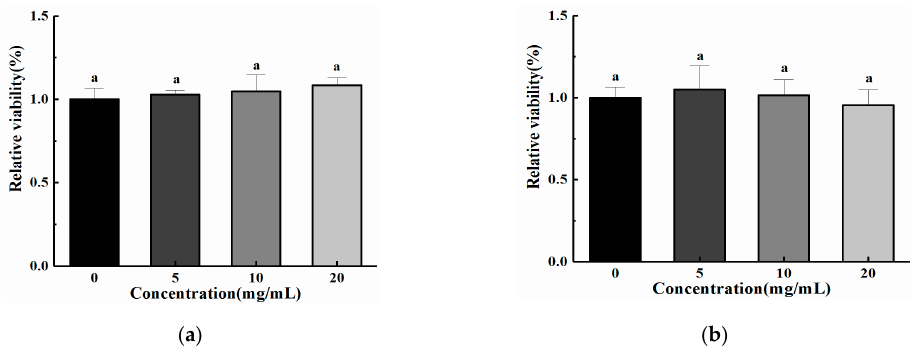
Figure 3. Detection of toxicity of xanthan gum hydrogel ( a ) and xanthan gum eutectogels with 20% water content ( b ) by MTT assay. “a” is xanthan gum